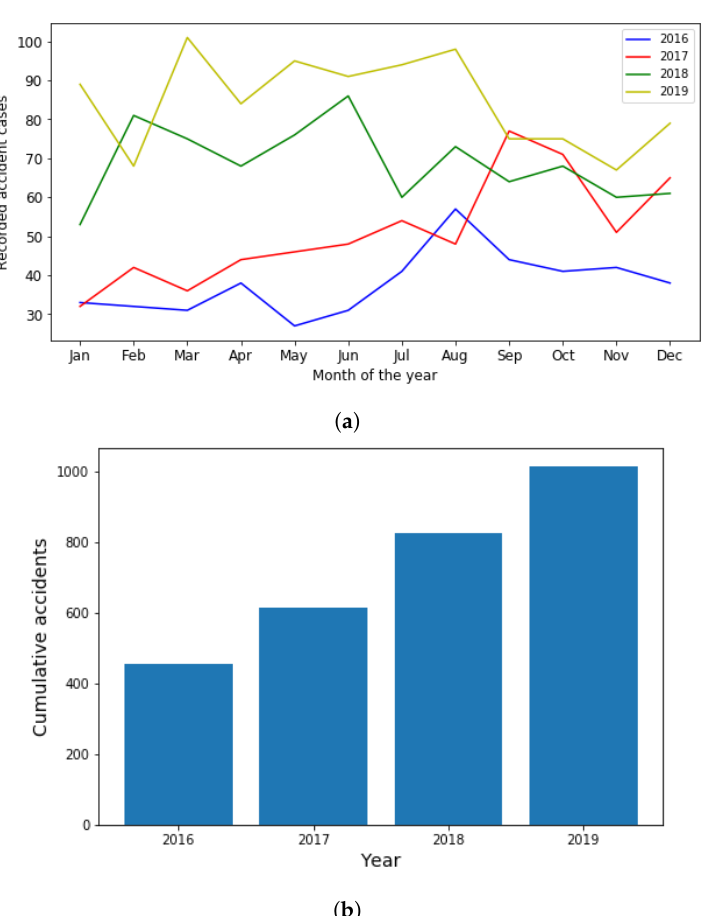
Figure 2. ( a ) Monthly variation of excessive speeding road accidents; and ( b ) cumulative number of excessive speeding due accidents by year